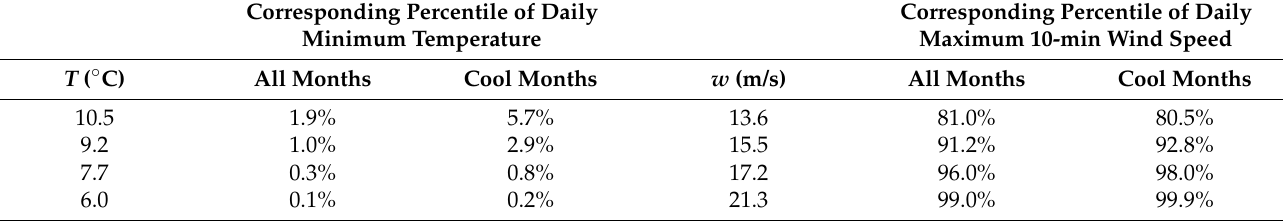
Corresponding Percentile of